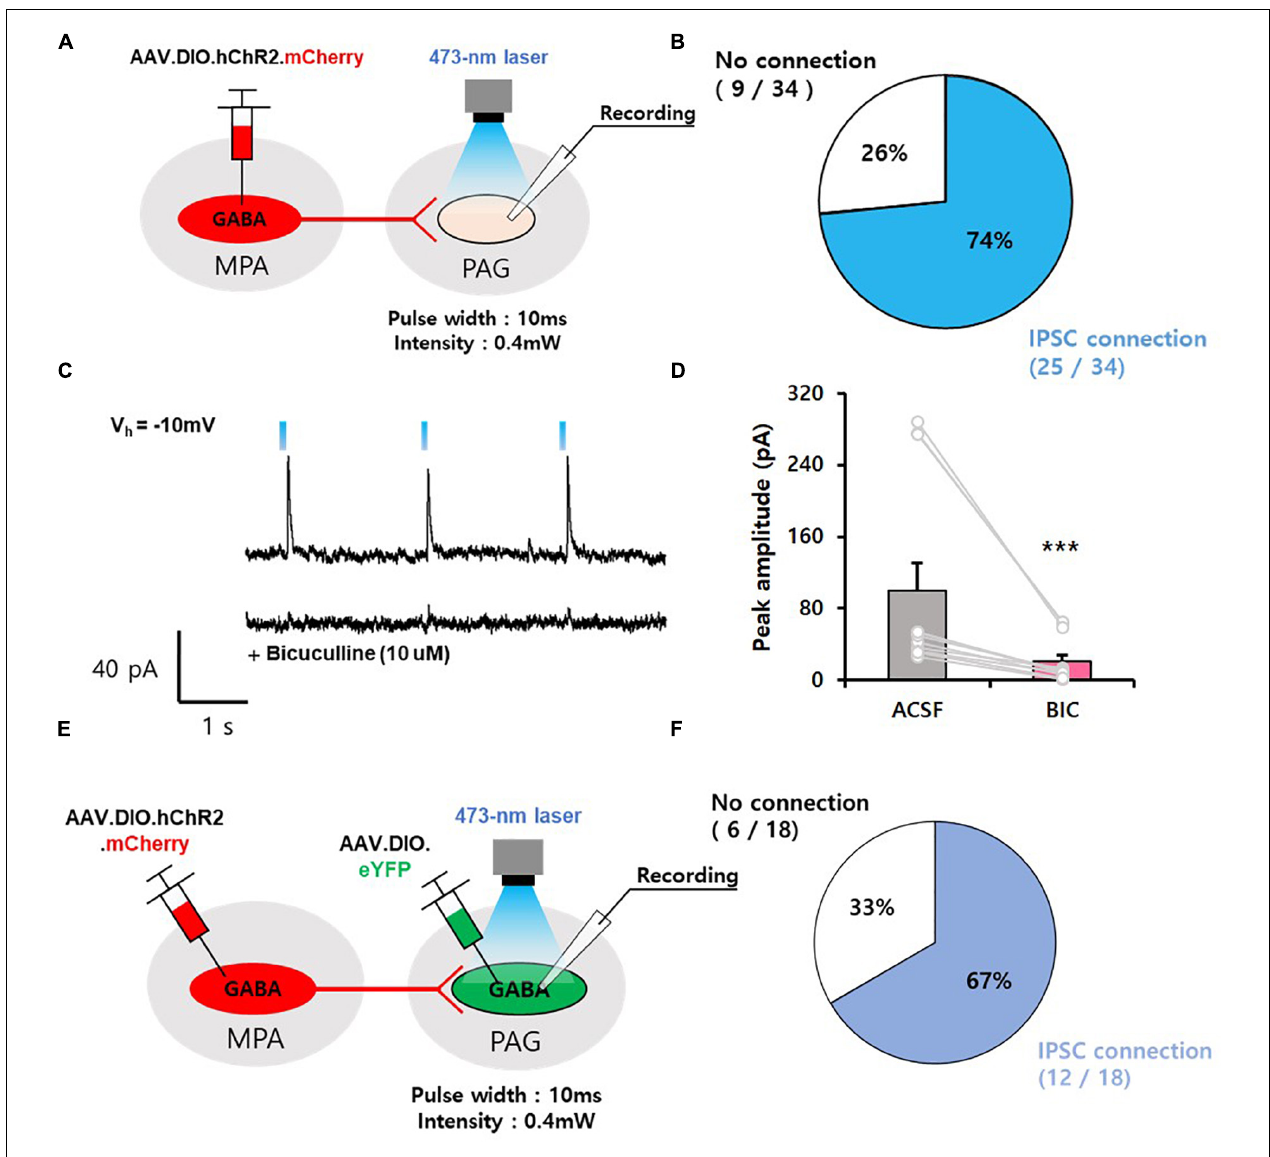
FIGURE 2 | GABAergic neurons in the MPA send inhibitory input to GABAergic neurons in the vPAG. (A) Mapping connections from MPA vgat neurons onto vPAG neurons using ChR2-assisted circuit mapping (CRACM). (B) Percentage of IPSCs evoked in postsynaptic vPAG neurons exposed to photostimulation. (IPSC connection, n = 2 5 cells; no connection, n = 9 cells). (C) Top, representative IPSC traces of vPAG neurons. Bottom, trace of single photostimulation, resulting in an IPSC, which was abolished by bicuculline (10 µ M). (D) Photostimulation of MPA vgat axon termini in the vPAG induces IPSCs that are abolished by pharmacological blockade of GABA A receptors with bicuculline ( n = 12); *** p < 0.001. Error bars represent SD. (E) Schematic of experiment, injection of AAV.DIO.hChR2.mCherry into the MPA and injection of AAV.DIO.eYFP into the vPAG of vgat -ires- Cre mice, followed by voltage clamp recordings of eYFP-positive cells in the vPAG. (F) Percentage of IPSCs evoked in postsynaptic vPAG vgat neurons exposed to photostimulation. (IPSC connection, n = 12 cells; no connection, n = 6